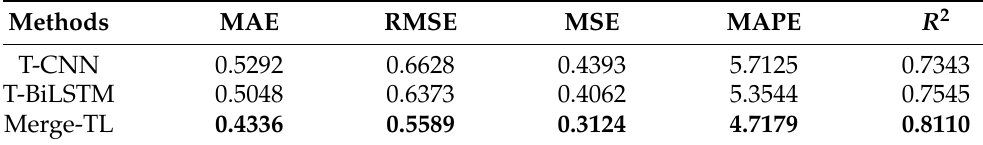
Table 3. The comparison experimental results of the 2 h prediction for S7.